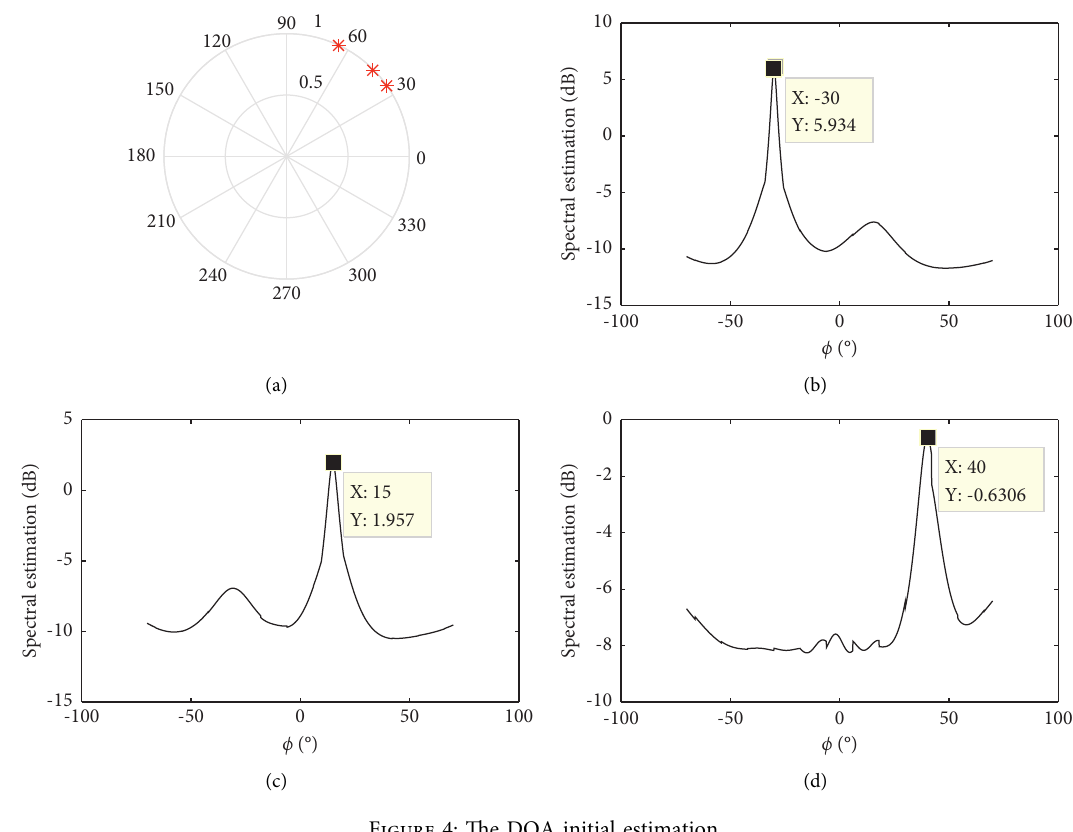
Figure 4: The DOA initial